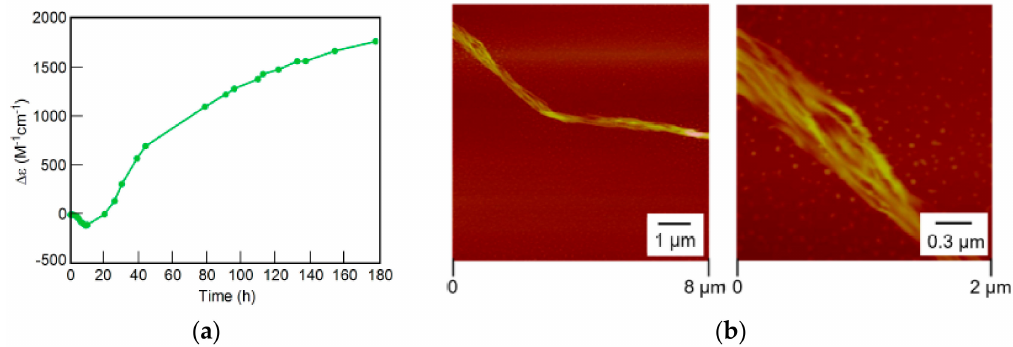
Figure 31. ∆ ε /time profiles of kinetics in the formation of self-assembly gels by mechanical stirring as shown by ( a ) and AFM images ( b ). Reproduced from reference 101 by permission from John Wiley & Sons.